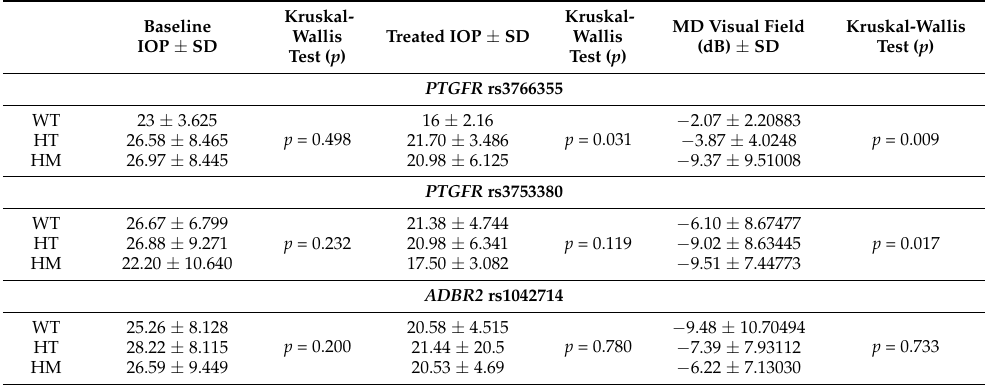
Table 3. IOP and visual field parameters according to the genetic